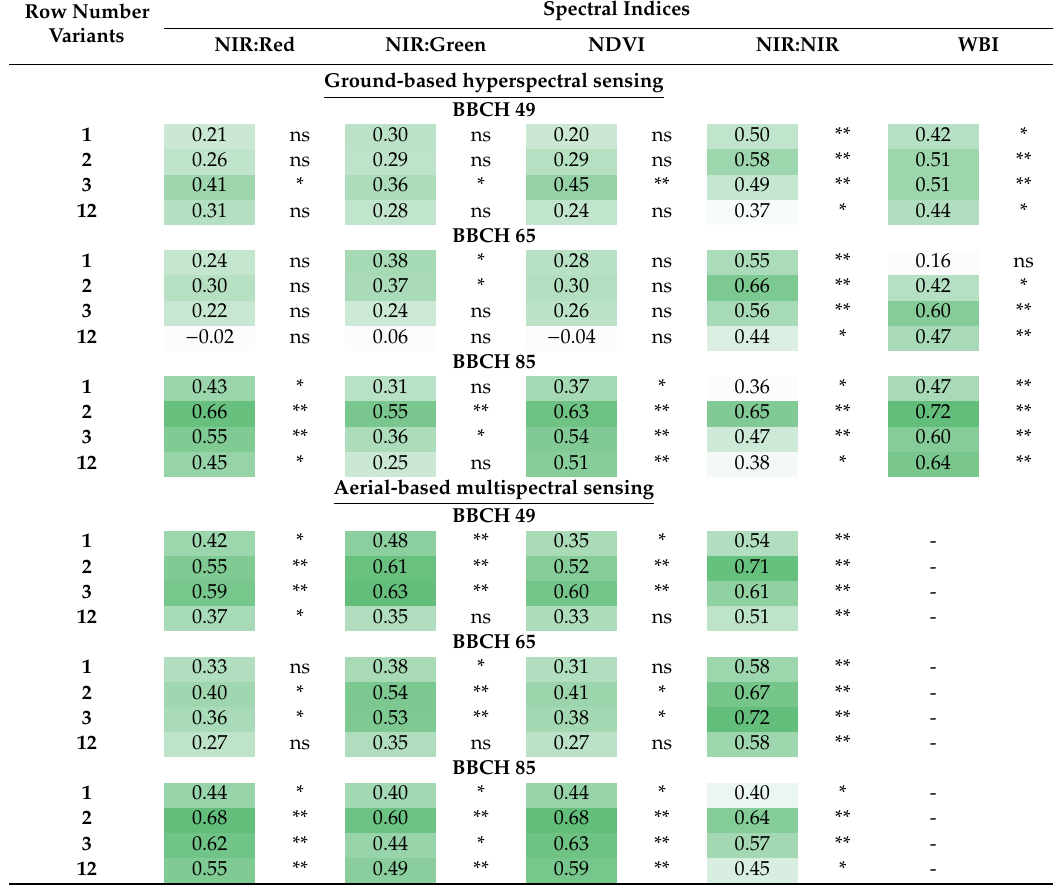
Table 3. Phenotypic correlation between the grain yield and spectral indices from ground- and aerial-based sensing in di ff erent row variants at BBCH scale stages 49, 65, and 85. Row Number